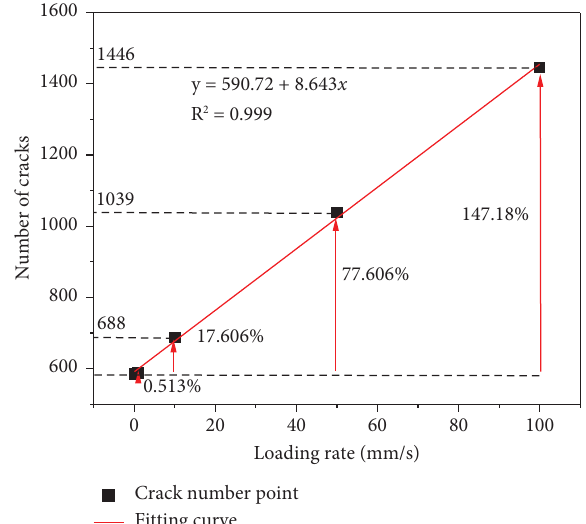
Figure 5: Peak strain change curve of the backfll model.